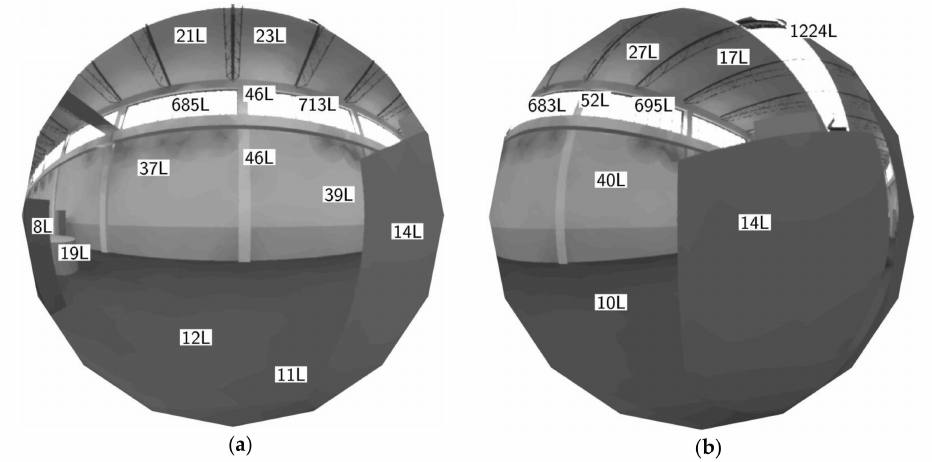
Figure 6. Result of simulated point values of brightness (luminance value cd.m − 2 ) at the workplace using di ff use skylight glazing: ( a ) overcast sky, north view; ( b ) overcast sky, northeast view.